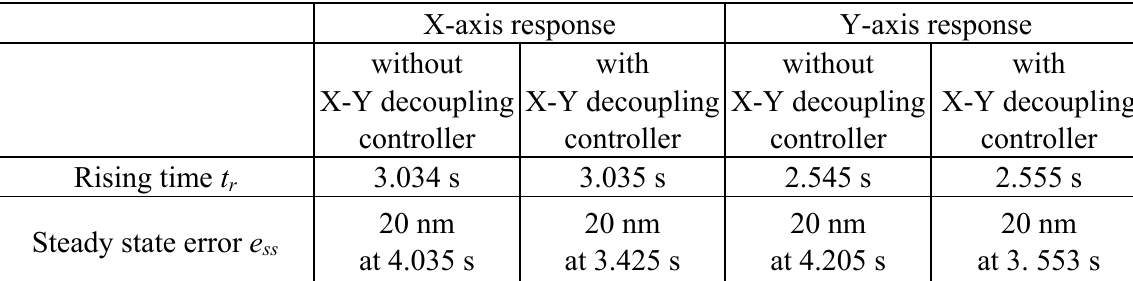
Table 3. Comparison of the positioning responses of X- and Y-axial pneumatic-piezoelectric hybrid actuators with and without X-Y decoupling